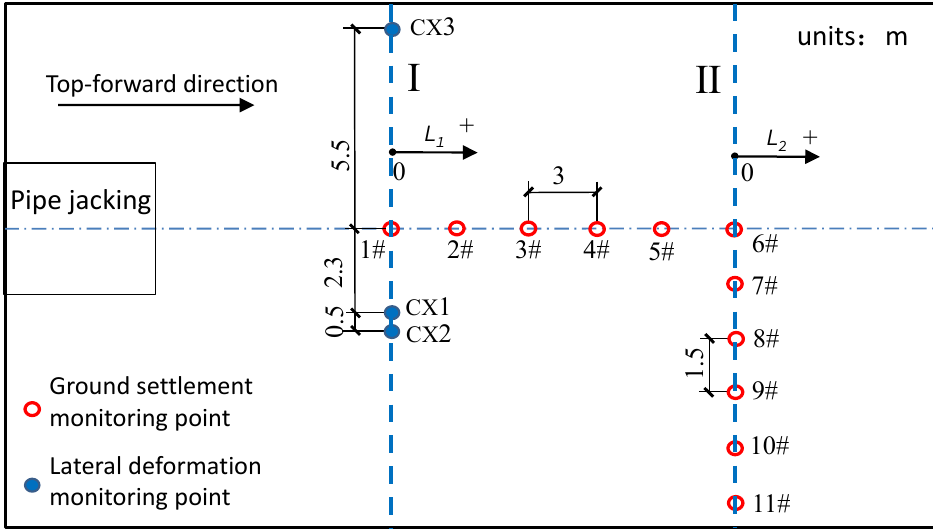
Figure 2. Layout plan of on-site monitoring